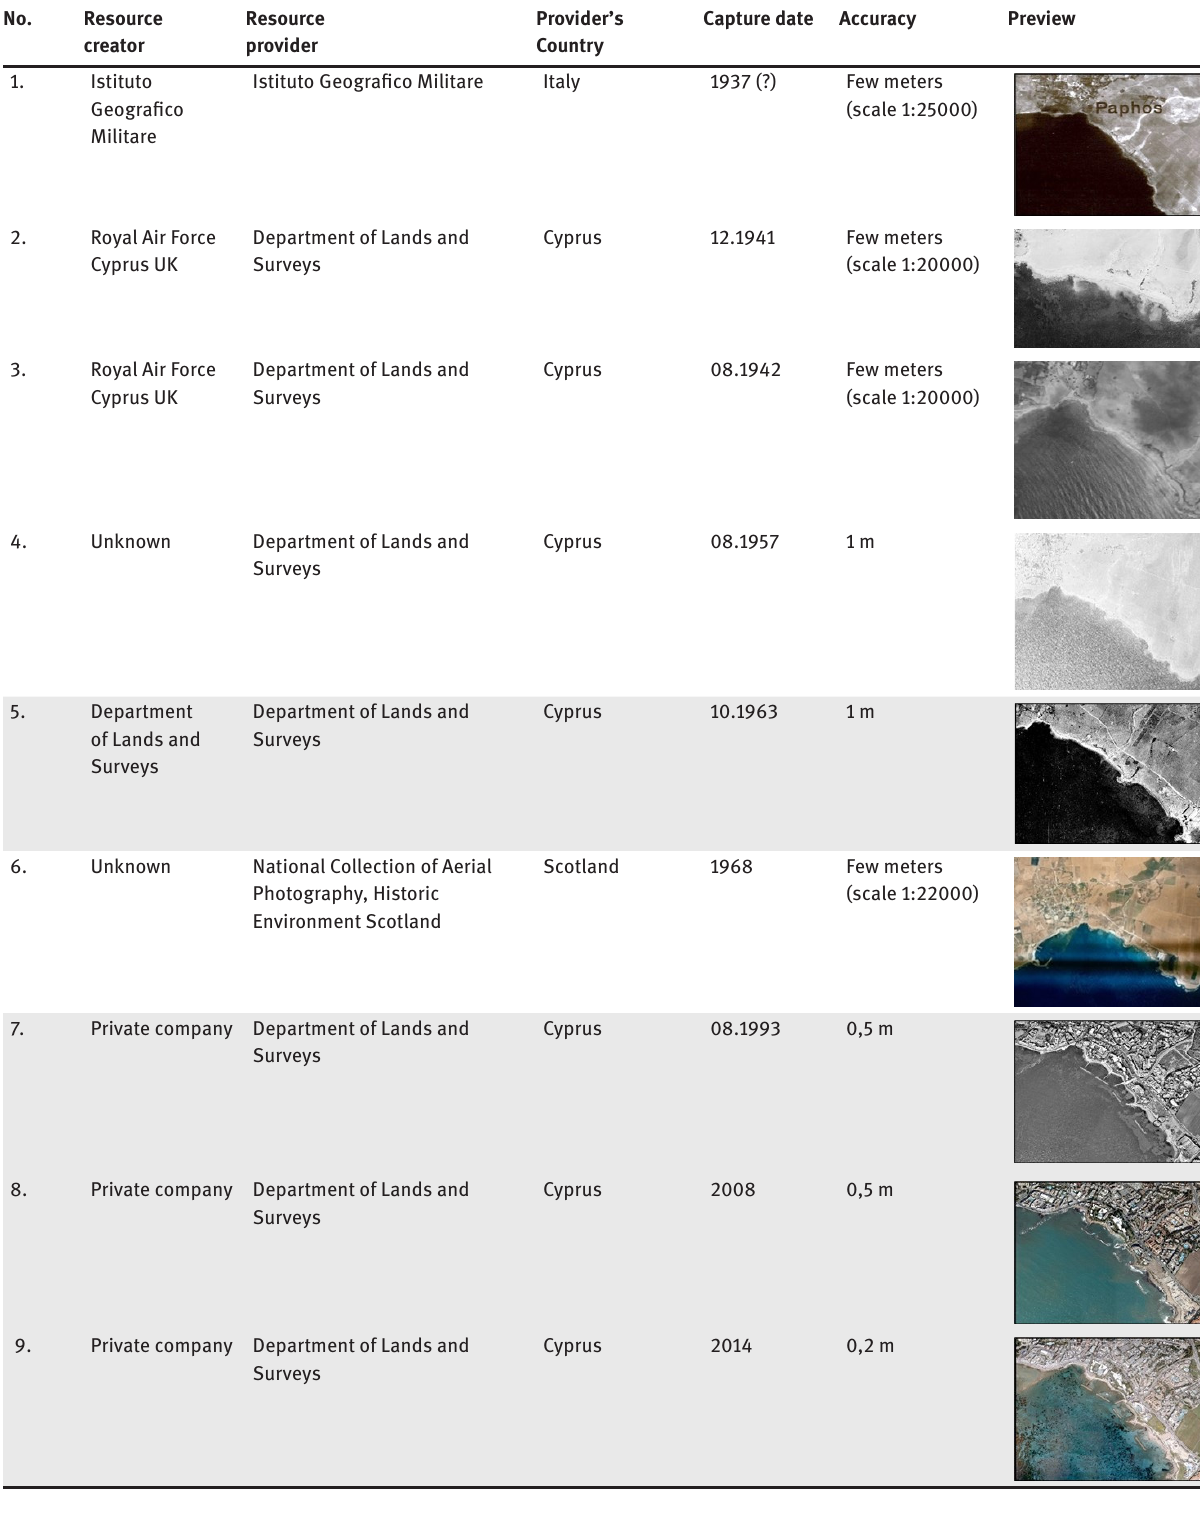
Table 1: Available aerial data of the Eastern necropolis of Nea Paphos, Cyprus.